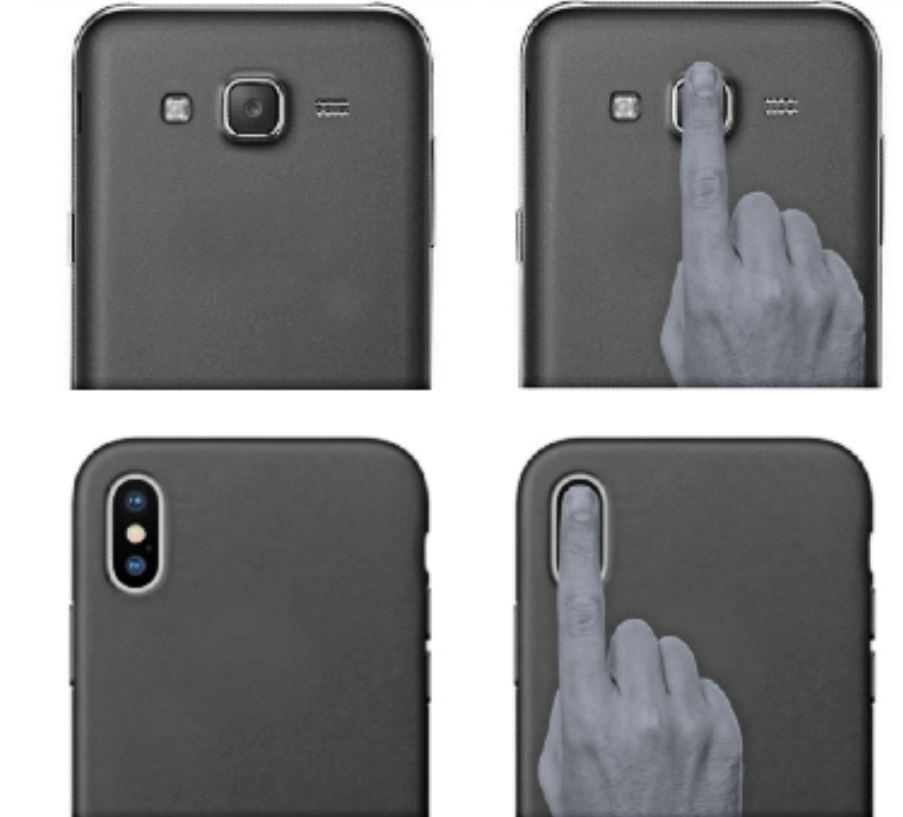
Figure 2. Correct placement of the index fingertip on different locations of the camera lens to obtain a correct heart rate measurement by photoplethysmographic